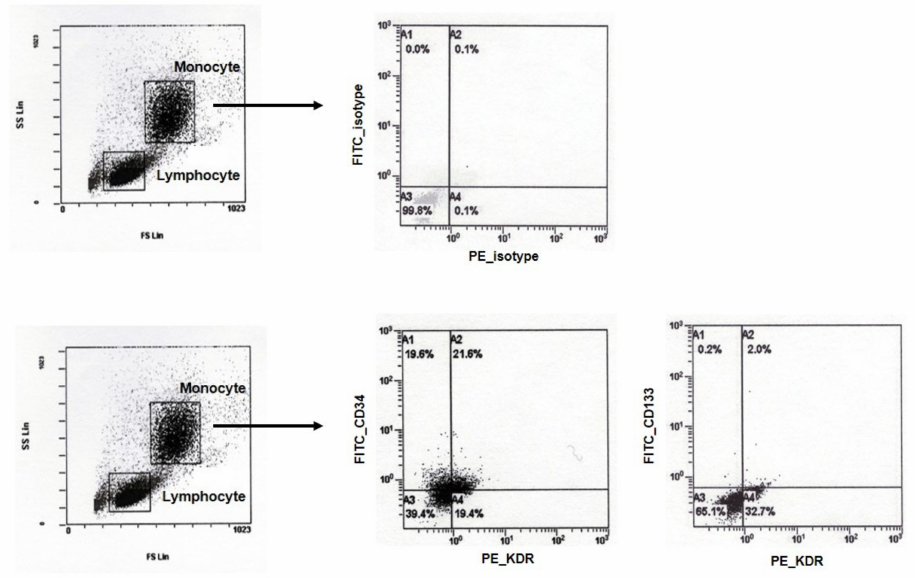
Figure 2. Measurement of circulating endothelial progenitor cells. Peripheral blood mononuclear cells (PBMNCs) were isolated by density gradient centrifugation over Ficoll. PBMNCs were analyzed for expression of CD34, CD133, and KDR. Quantitative analyses were performed by using flow cytometry. FITC = fluorescein isothiocyanate; PE =